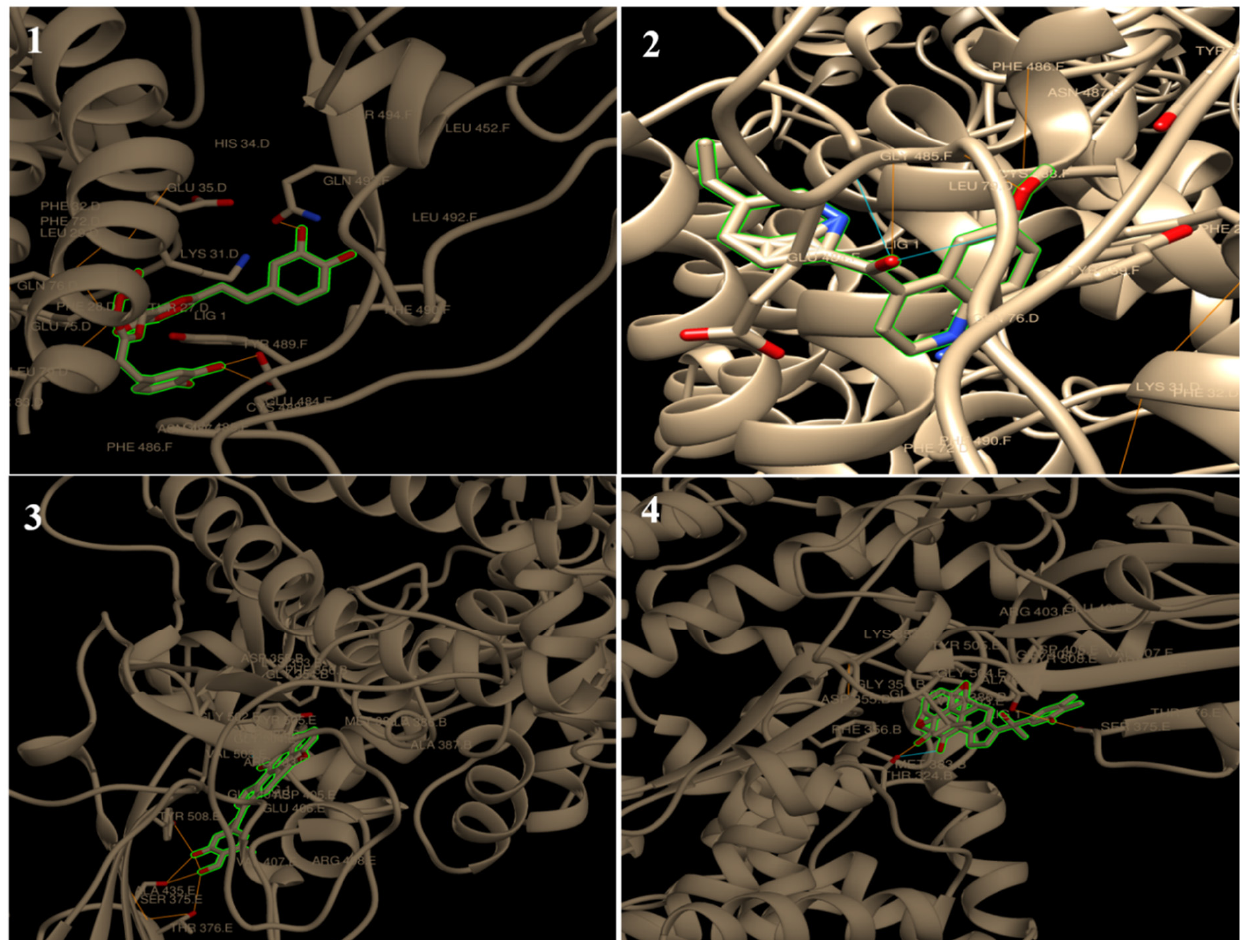
Figure 4. Chimera visualization of 6M17 docking with chicoric acid ( 1 ), quinine ( 2 ), withaferin A ( 3 ) and withanolide D ( 4 ). The yellow dots show H-bonds.